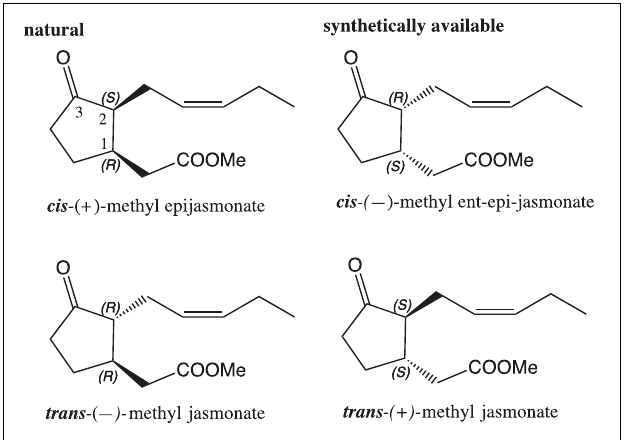
FIGURE 3 | Natural and synthetically available structures of methyl jasmonate